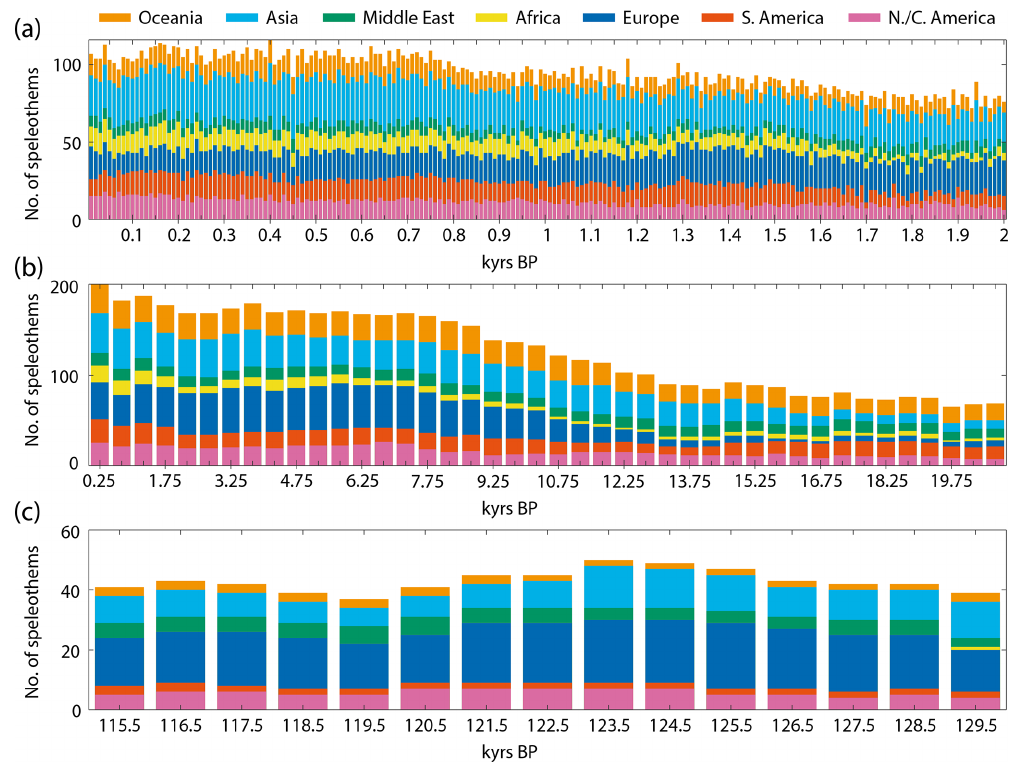
Figure 7. Global and regional temporal coverage of entities in the SISALv2. (a) Last 2000 years, with a bin size of 10 years; (b) last 21000 years, with a bin size of 500 years; (c) the period between 115000 and 130000 years BP, with a bin size of 1000 years. BP refers to “before present”, where present is 1950CE. Regions defined as in Table 7.